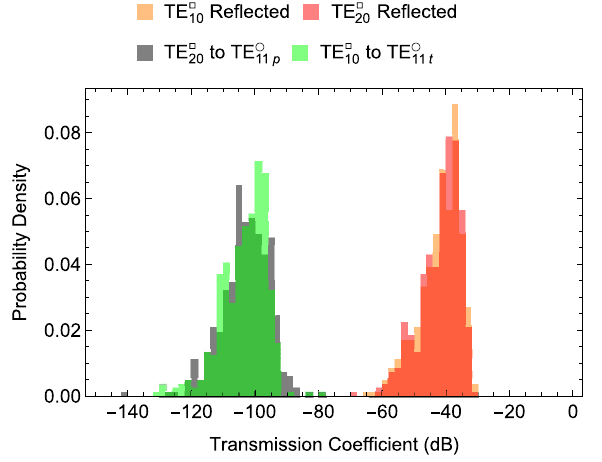
FIG. 18. Cylindrical TE ○ 11 to rectangular TE □ 10 = TE □ 20 mode converter s-parameters tolerances, obtained by varying 7 geo- metrical parameters uniformly (cid:2) 5 μ m.